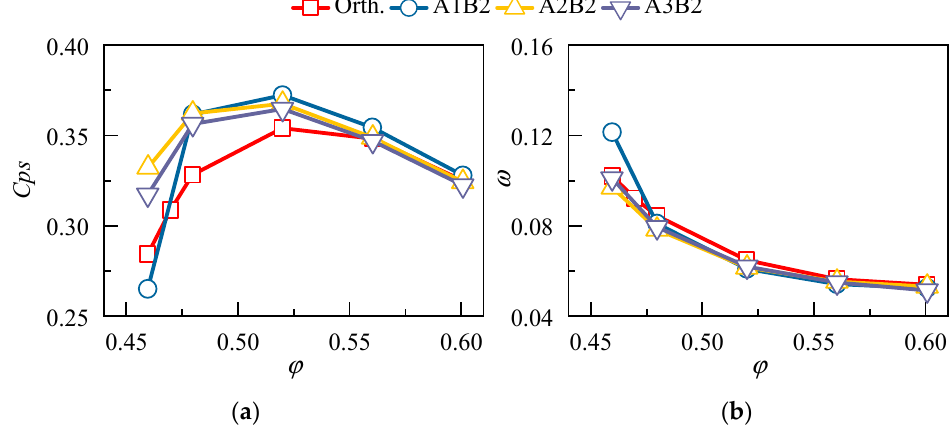
Figure 5. Pressure rise and loss characteristics for the stator with different sweep heights. ( a ) Pressure rise and ( b ) loss.